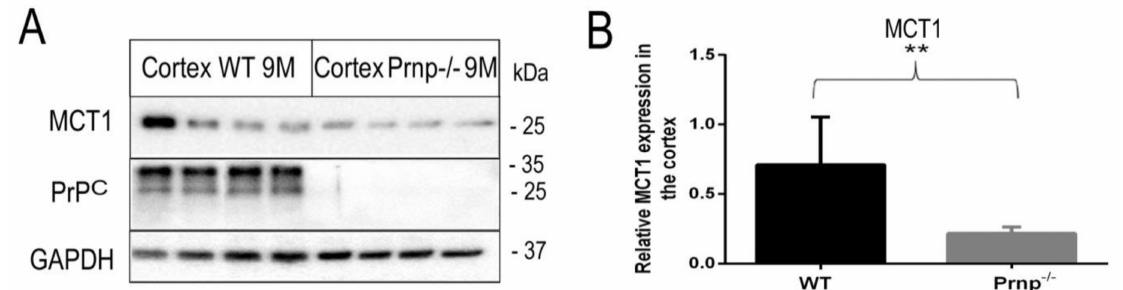
Figure 2. Western blot and densitometric analysis of MCT1 and PrP c expression in the cortex of 9-month-old WT and Prnp − / − mice. ( A ) Homogenates prepared from cortex were examined for MCT1 and PrP c expression by Western blotting. All brain homogenates of WT mice exhibited PrP c expression (diglycosylated at 35 kDa, monoglycosylated at 33 kDa and unglycosylated at 26 kDa), whereas Prnp − / − mice blots confirmed the absence of PrP c . An equal protein load (20 µ g per lane) is shown by GAPDH expression. ( B ) Densitometric quantification of band intensities via Image Lab 6.0.1 revealed a higher protein expression of MCT1 in WT as compared to Prnp − / − mice. The analyses were performed on n = 4 animals per group in three different Western blots. Displayed are means ± SEM. A p -value < 0.01 is considered as very significant